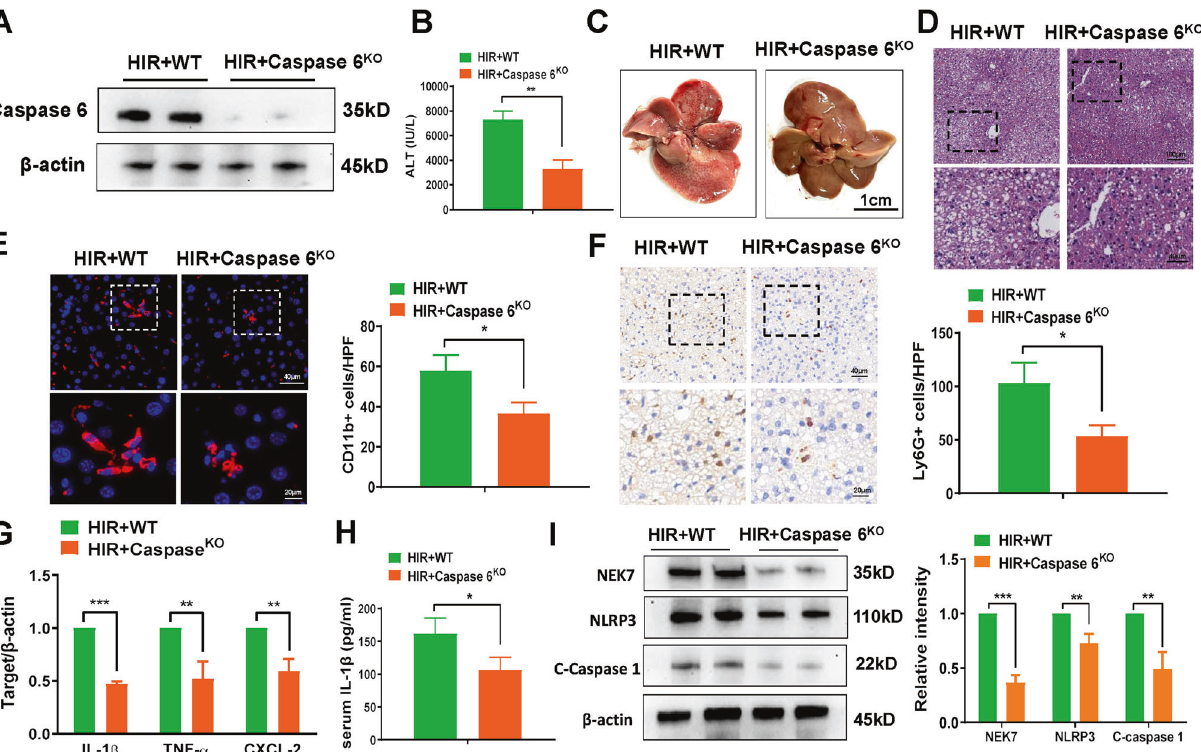
Fig. 2 Caspase 6 deletion alleviates liver damage and in fl ammatory response during fatty liver IR injury. WT and Caspase 6 KO mice were used to establish fatty liver IR (HIR) models. Samples were harvested after 90 min ischemia and 6 h of reperfusion. A Liver Caspase 6 expression was evaluated by Western blot assay. B sALT level was detected in ischemic livers; ( C ) Representative images of livers after IR surgery, scale bar: 1 cm; ( D ) Representative H&E staining in ischemic liver tissue. scale bars: 100 μ m, 40 μ m; ( E ) IF staining and quanti fi cation of CD11b + macrophages in ischemia livers, scale bars: 40 μ m, 20 μ m; ( F ) IHC staining and quanti fi cation of Ly6G + neutrophiles in ischemia livers, scale bars: 40 μ m, 20 μ m; ( G ) Detection of cytokines IL-1 β , TNF- α and CXCL-2 by qRT-PCR in ischemic livers; ( H ) ELISA analysis of serum IL- 1 β levels; ( G ) Western blotting analysis and relative intensity of NEK7, NLRP3 and C-Caspase 1. N = 4 – 7/group, all data represent the mean ± SD, * p < 0.05, ** p < 0.01, *** p <